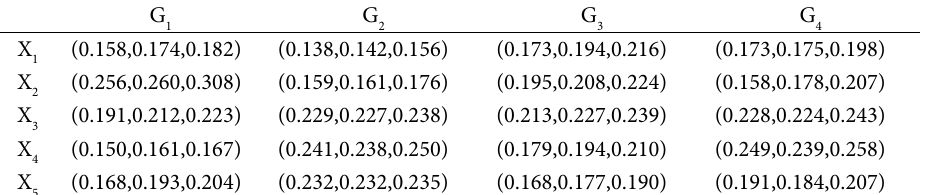
Table 6. Decision matrix 3 R 